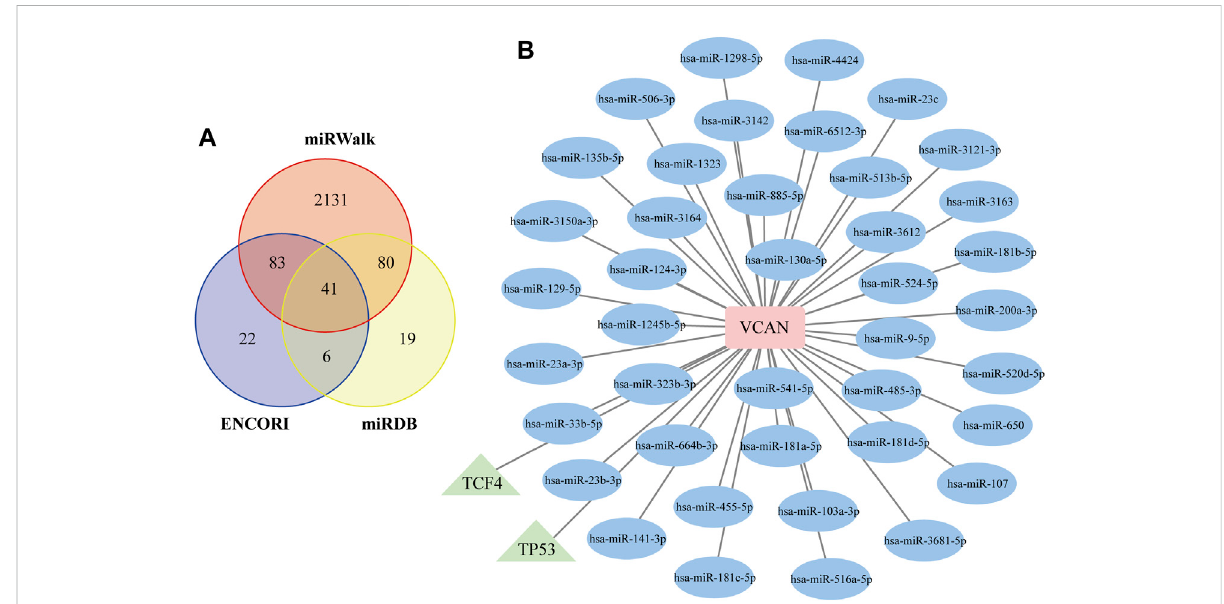
FIGURE 8 Construction of the TF – VCAN – miRNA Regulatory Network. (A) Venn diagram of the intersection of targeted miRNAs screened by ENCORI, miRWalk, and miRDB databases. (B) TF – VCAN – miRNA regulatory network. The square represents the gene, the circle represents miRNA, and the triangle represents